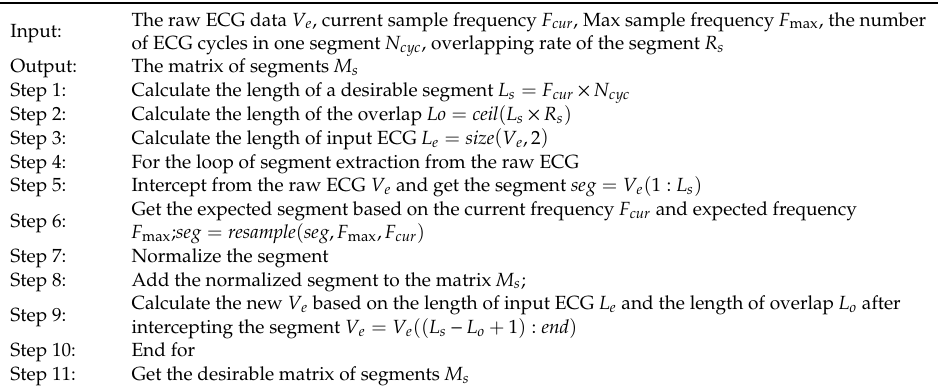
Table 4. The implementation flow of the